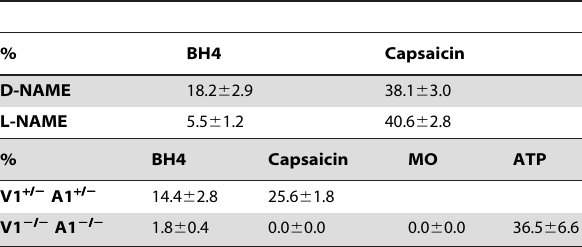
Table 3. Endogenous NO activates DRG neurons via TRPV1 and TRPA1.